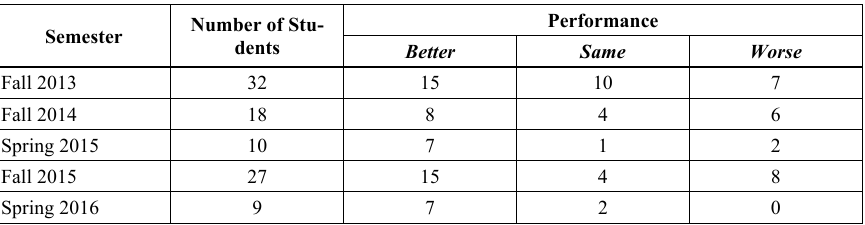
Table 4. Performance comparison for course and capstone